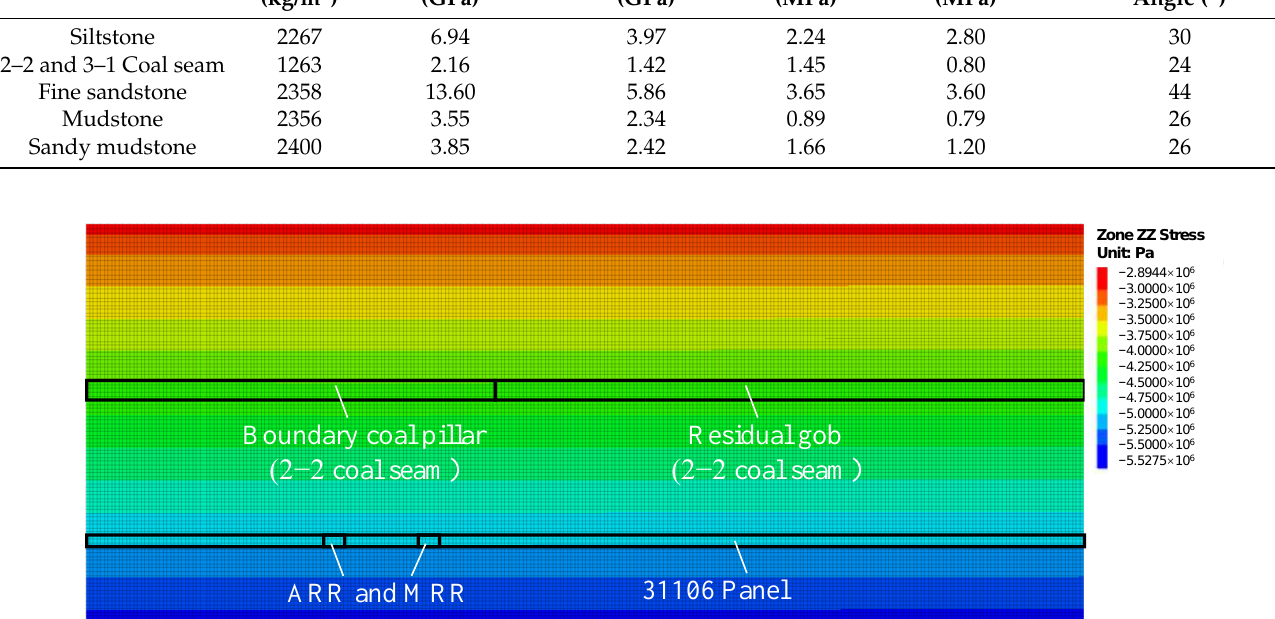
Figure 3. Schematic diagram of numerical model for mining under residual pillar (vertical stress cloud chart).